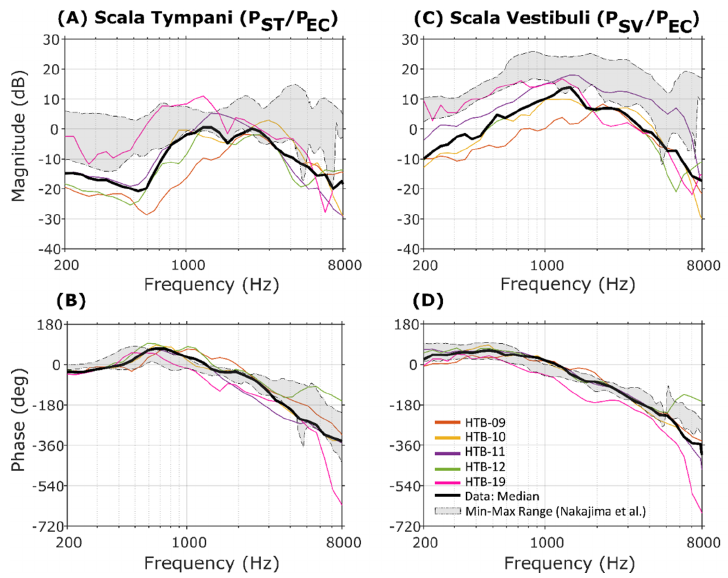
Figure 4. Simultaneous ICSP measurements in ST and SV: magnitude of the pressure gain in ST ( P ST / P EC ) ( A ) and in SV ( P SV / P EC ) ( B ); respective phase data for ST ( C ) and SV ( D ).